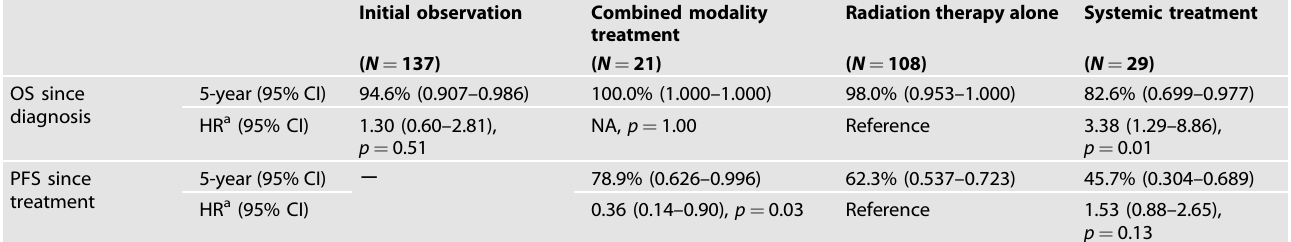
Table 3. Survival analysis in all eligible patients with stage I – II follicular lymphoma based on management approach.